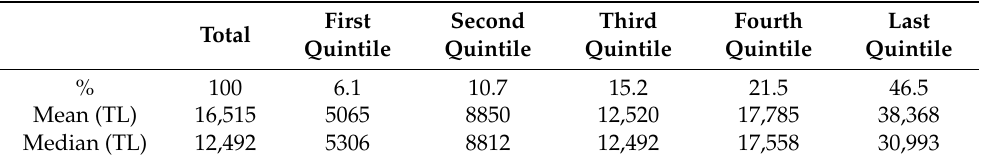
Table 1. Distribution of annual equivalized household disposable income by quintiles ordered by equivalized household disposable income for 2015 prices in Turkish Lira (TL). First Second Third Fourth Last Total Quintile Quintile Quintile Quintile Quintile % 100 6.1 Mean (TL)